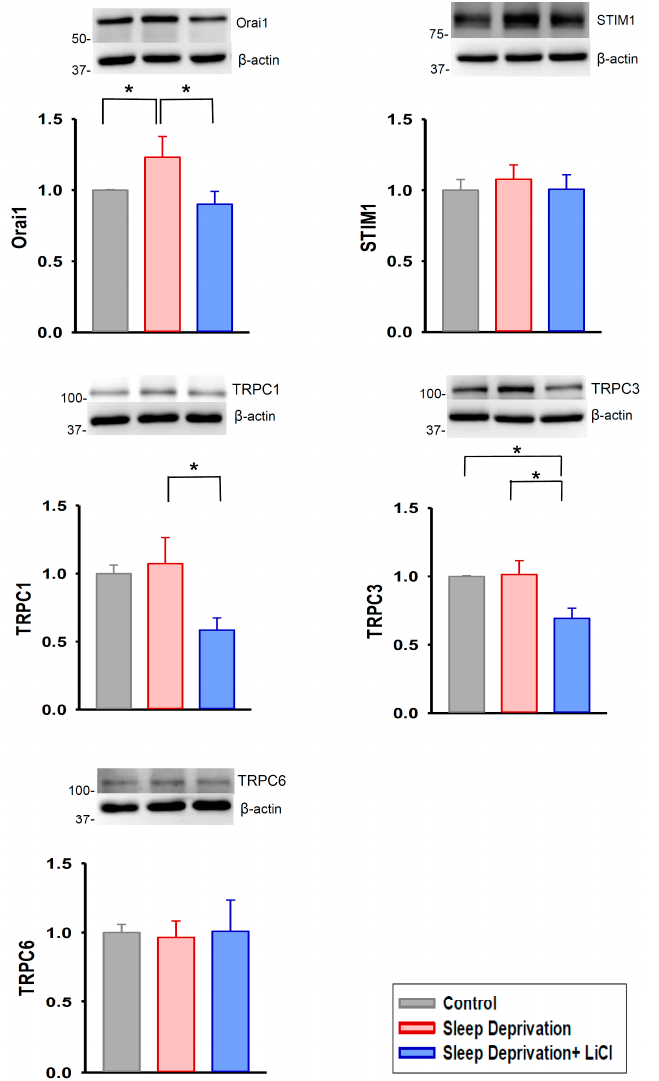
Figure 5. Expression levels of store-operated Ca 2+ entry channels in REM sleep deprivation with and without lithium treatment. Compared with the REM sleep-deprived hearts ( n = 5), the lithium-treated REM sleep-deprived hearts ( n = 5) had lower expression levels of calcium release-activated calcium channel protein 1 (Orai1), transient receptor potential canonical (TRPC) 1 channel, and TRPC3 channel. * p < 0.05.